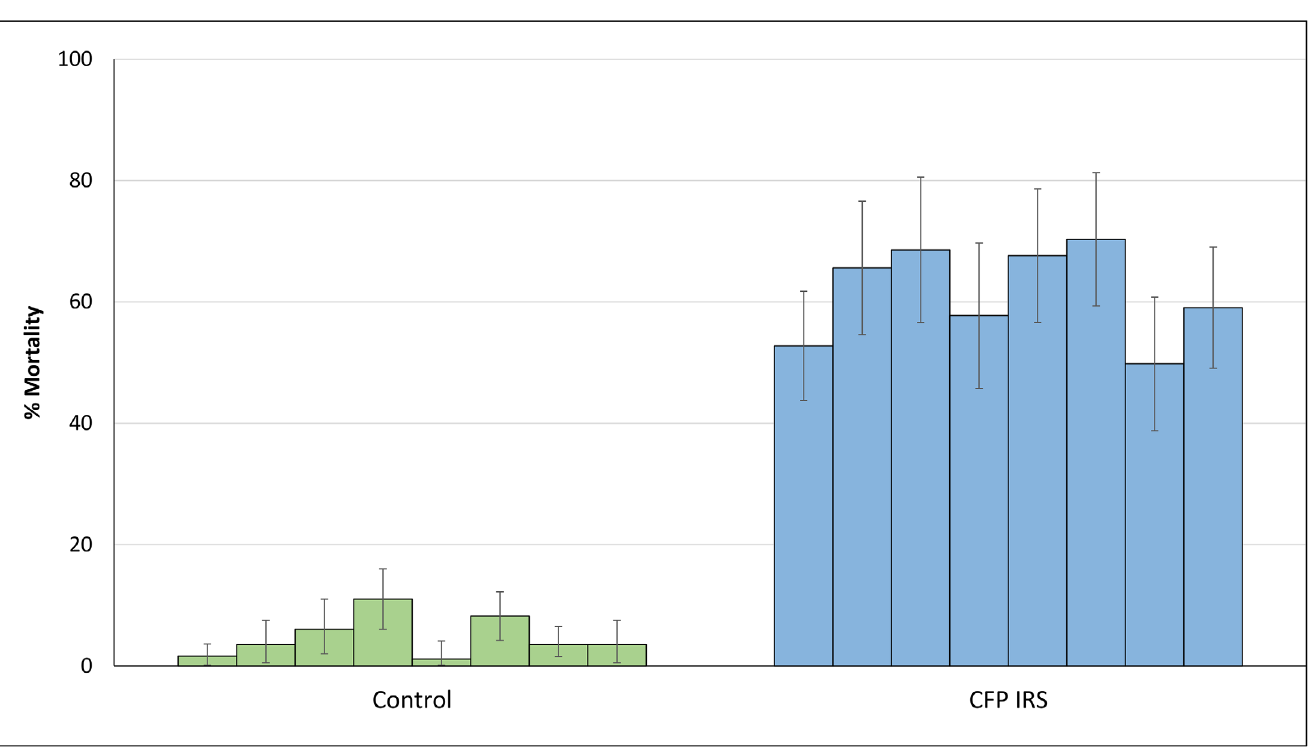
Fig 4. Fortnightly mortality rates of free-flying wild pyrethroid resistant Anopheles gambiae entering chlorfenapyr IRS-treated experimental huts in Cove, Benin. Each bar represents mortality data collected over 2 weeks. Data was collected over 4 months. Error bars represent 95% CI. alpha = alpha-cypermethrin, CFP = chlorfenapyr.